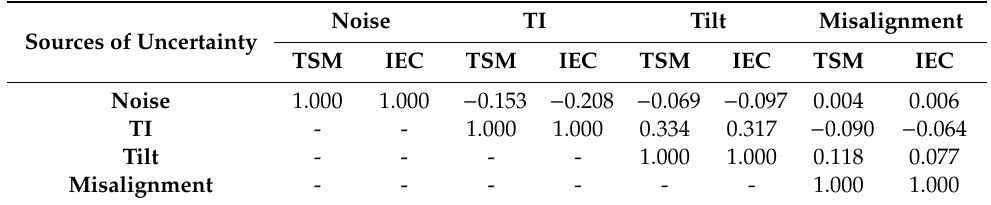
Table 4. Correlation matrix for errors of means of MRV. TI: Turbulence Intensity, IEC: International Electrotechnical Commission and TSM: Temporal-Spatial